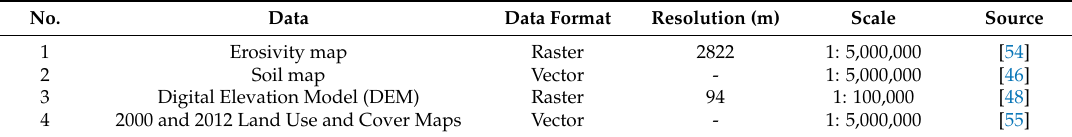
Table 1. Georeferenced input data applied in the Revised Universal Soil Loss Equation (RUSLE) model for the Brazilian